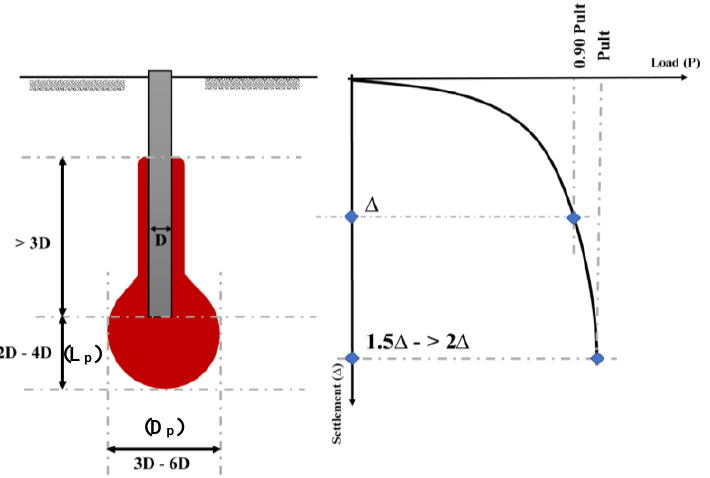
Figure 11. Relation between pile diameter and length and diameter of the formed plastic bulb below the pile base at the failure state.